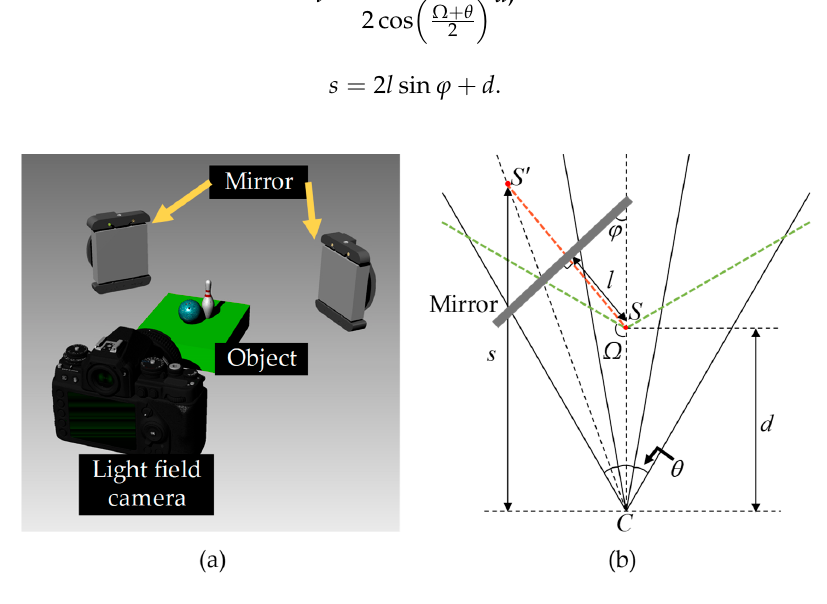
Figure 5. ( a ) Proposed light field pickup system and ( b ) geometrical figure for analysis on the proposed